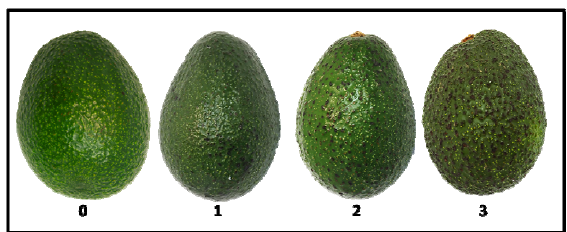
Figure 1. Hedonic scale for evaluating lenticel damage: 0 = fruit with no damage, 1 = fruit with damage less than 25%, 2 = fruit with damage greater than 25% but less than 50% and 3 = fruit with 50% or more of the surface damaged. Own elaboration.